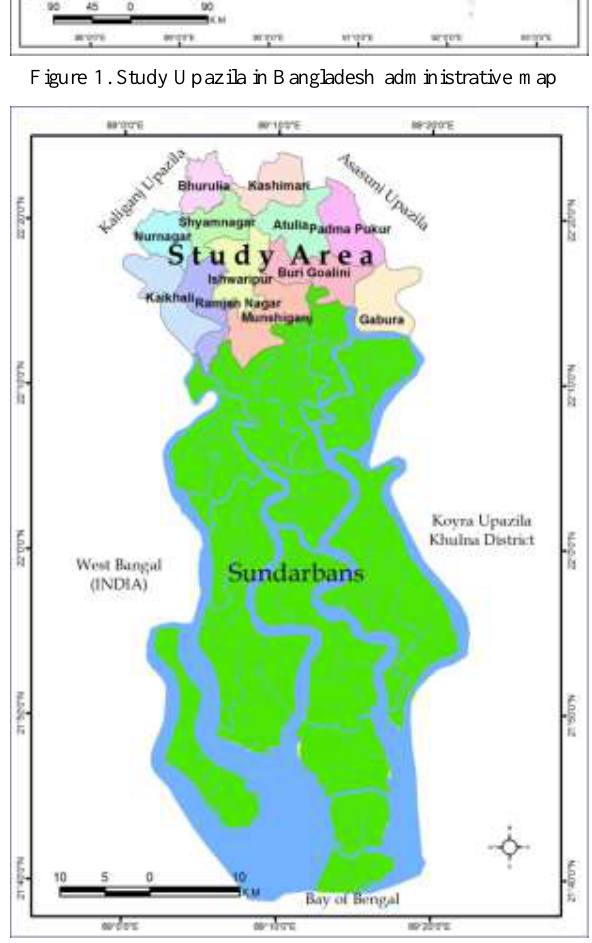
Figure 2. Study area in Shyamnagar upazila including Sundarban